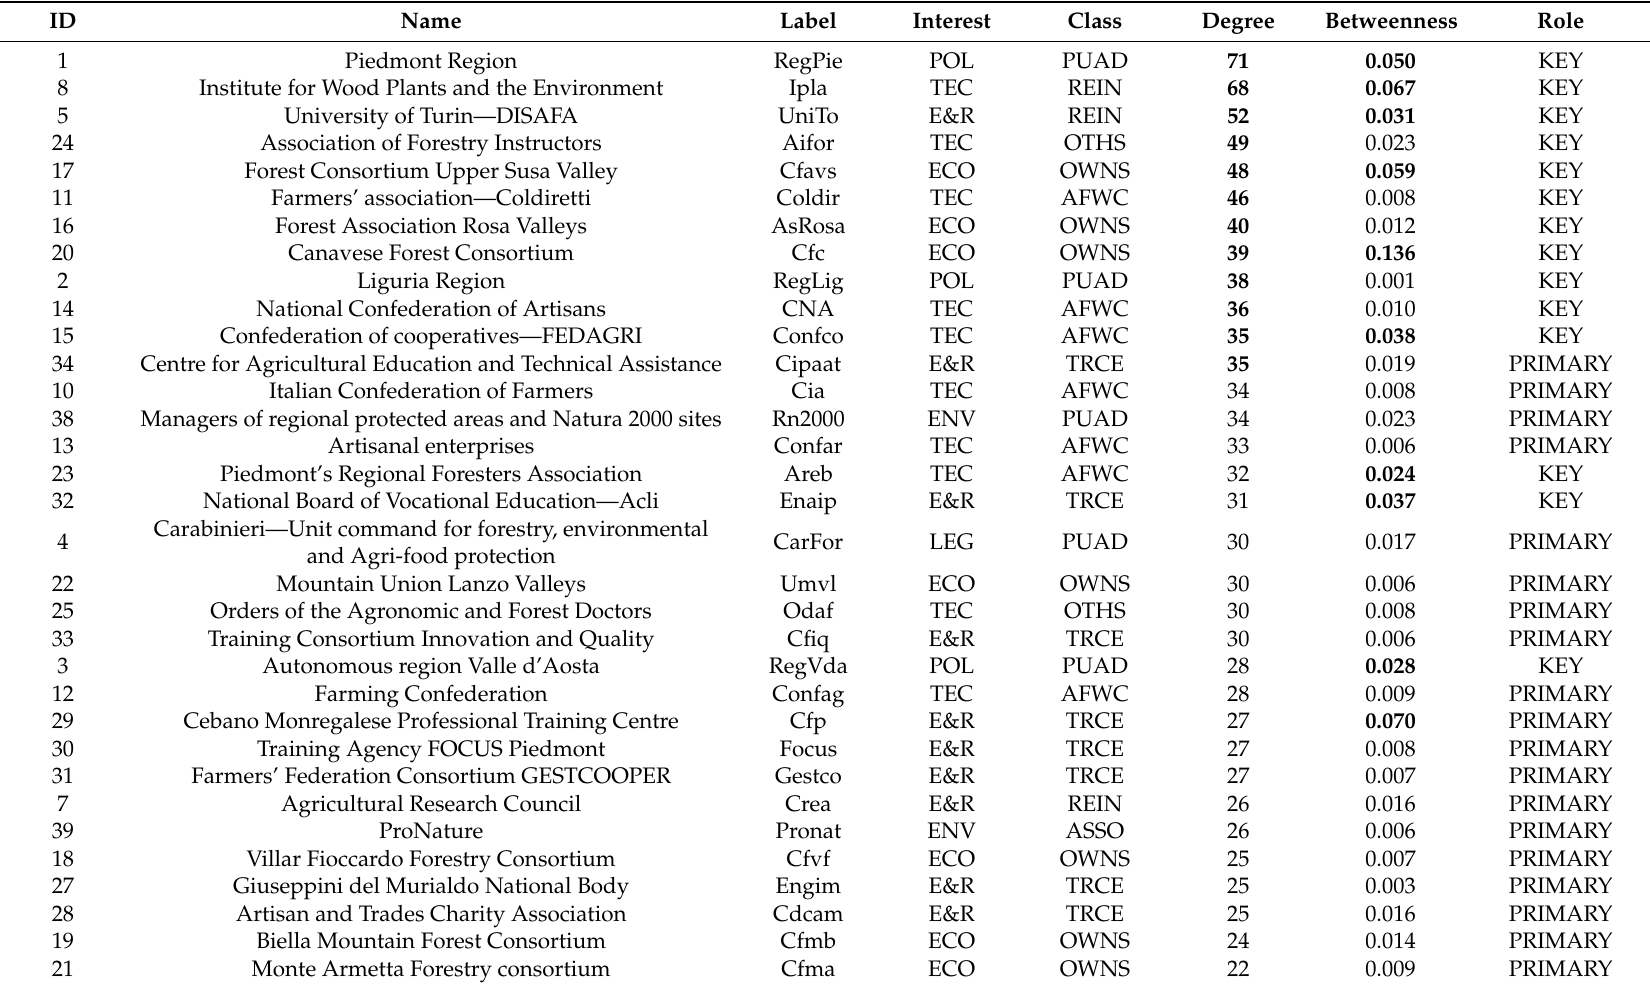
Table 3. Social Network Analysis